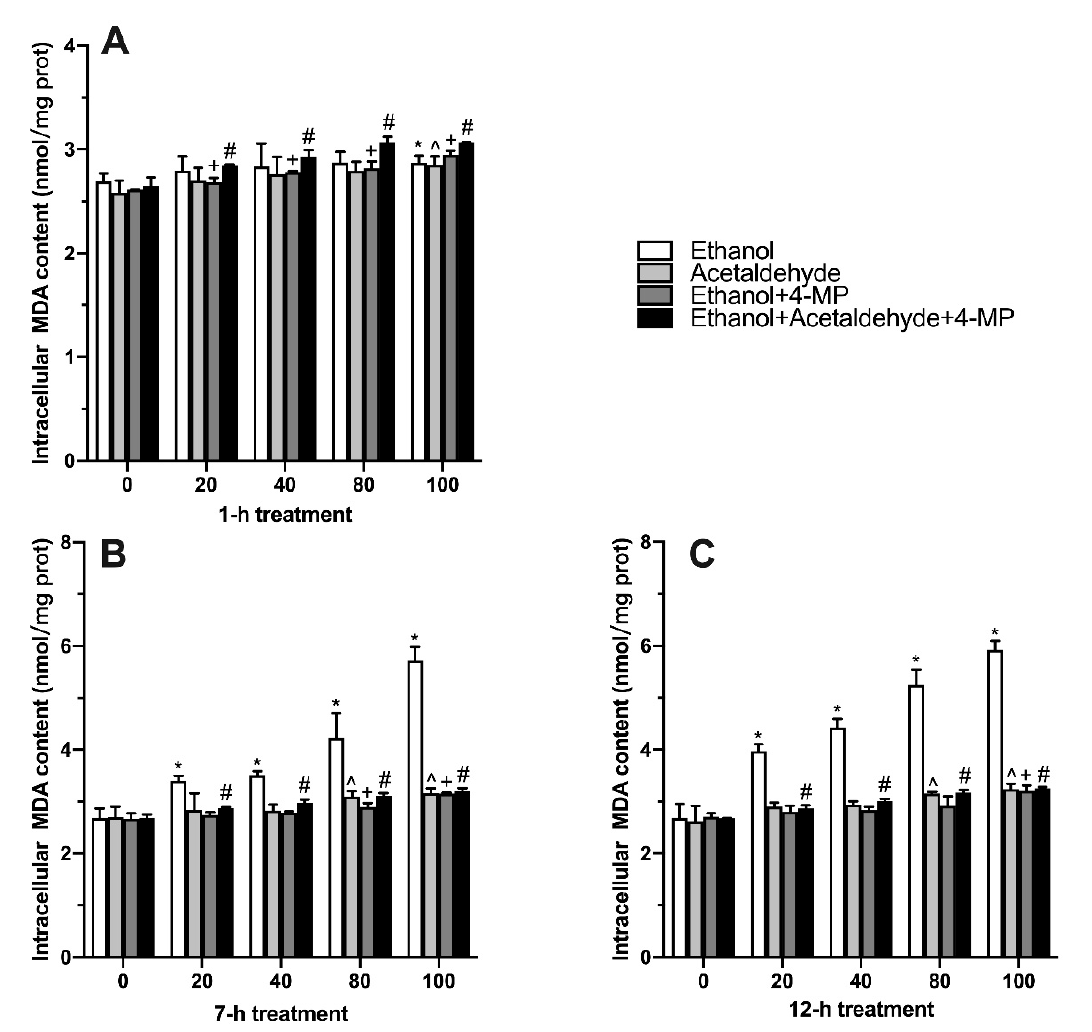
Figure 3. Effect of four different treatments on malondialdehyde content in L02 cell lines treated for 1 h ( A ), 7 h ( B ), and 12 h ( C ). Values represent means ± SD (n ≥ 6). * p < 0.05 compared with 0 mM ethanol, ^ p < 0.05 compared with 0 µM acetaldehyde, + p < 0.05 compared with 0 mM ethanol + 500 µM 4-MP, # p < 0.05 compared with 0 mM ethanol + 0 µM acetaldehyde + 500 µM 4-MP.